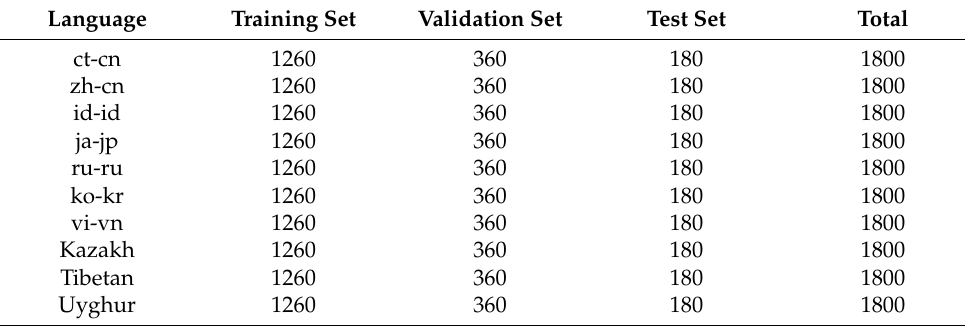
Table 2. Oriental language data set structure.